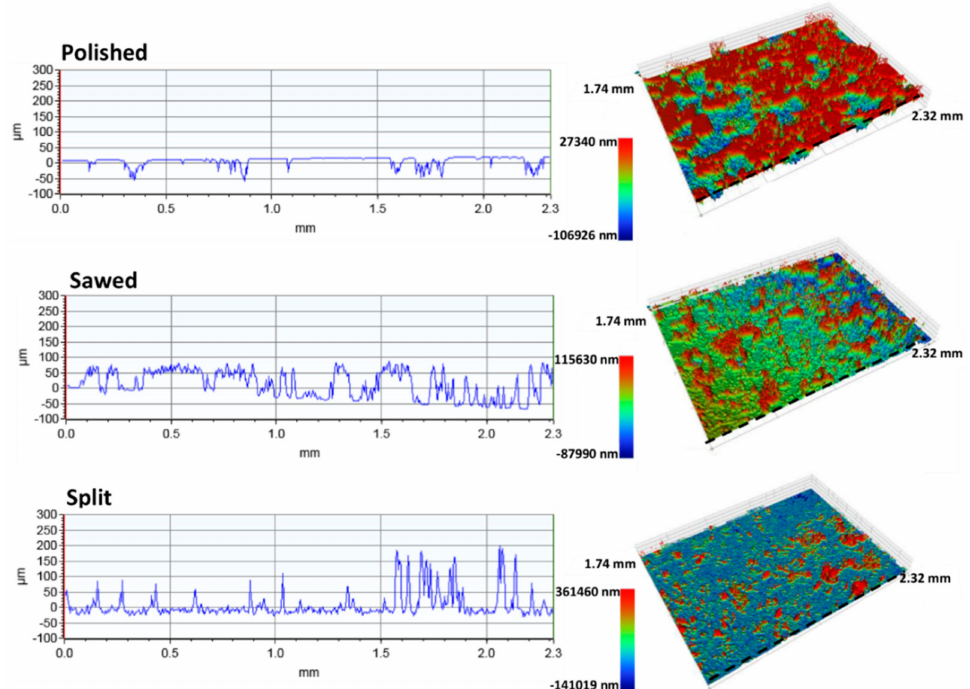
Figure 9. Surface roughness profiles and corresponding 3D models of the polished, sawed, and split surfaces of the Fontainebleau sandstone. Note that the 3D models have different topographic scales. Dashed line indicates location of the topographic